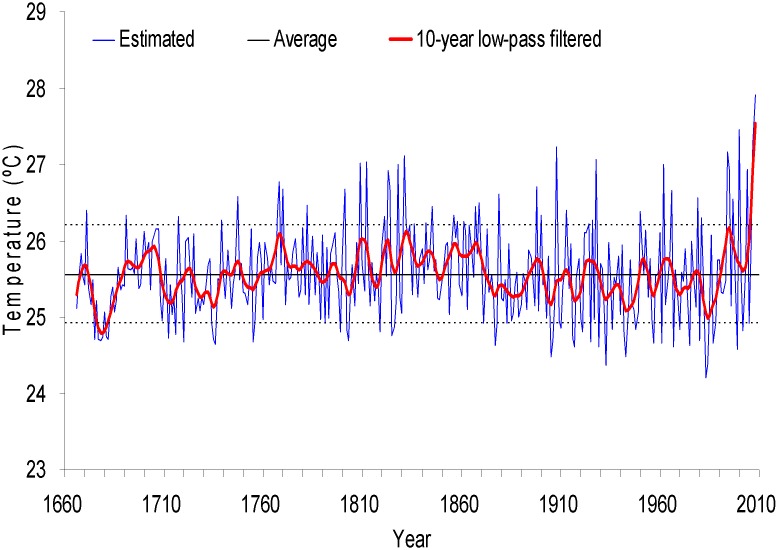
Estimated (thin line) and 10-year low-pass filter (thick line) values of May–June maximum temperature of Tianshui.Central horizontal line shows the mean of the estimated values; The dotted lines show the border of one standard deviation.